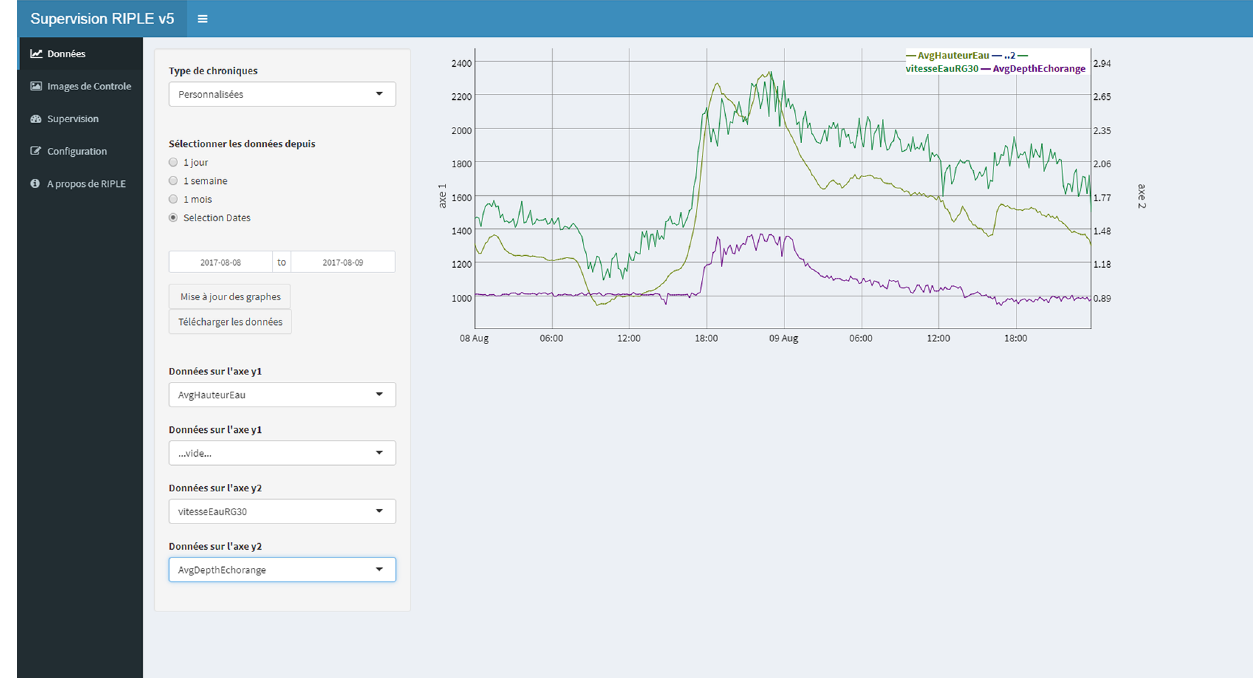
Figure 9. Screenshot of the “Data visualization” menu of the user interface in the personalized mode. A graph can be created with two variables on the first y axis and two variables on the second y axis, with time on the x axis. In this case, the water level, water surface velocity and distance measured by the echo sounder are